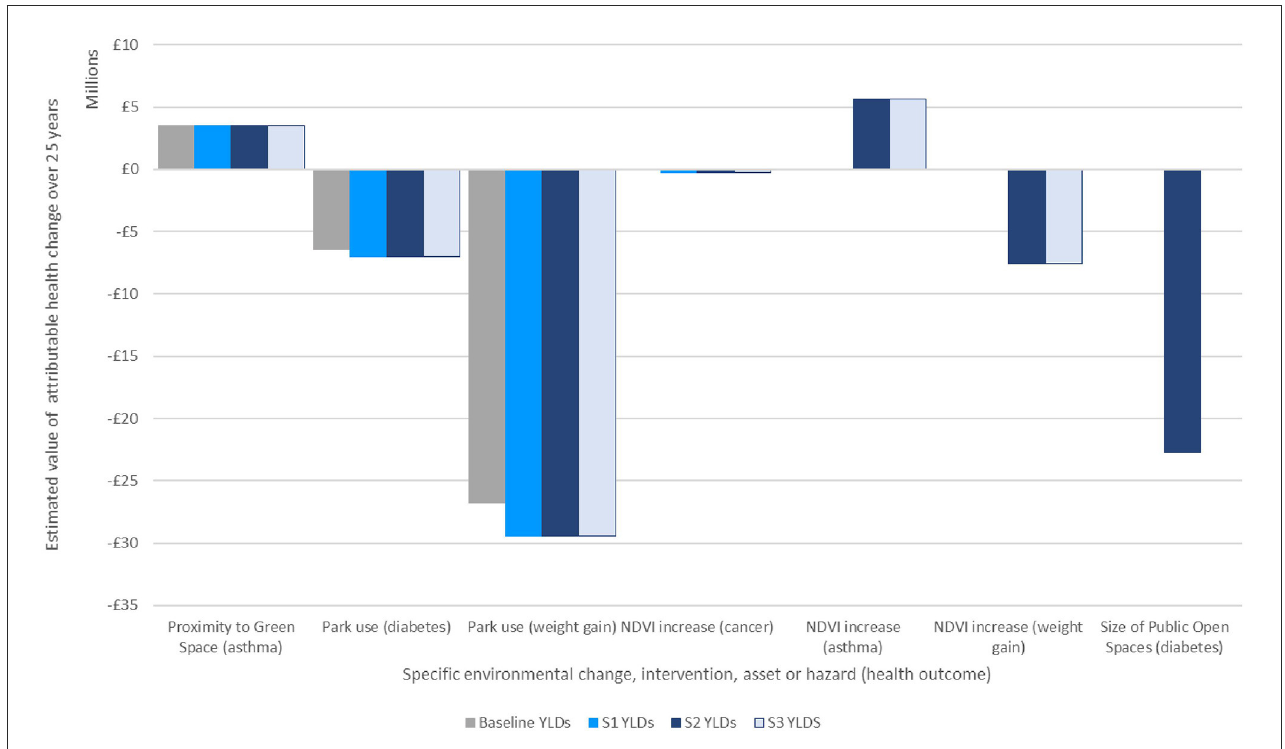
FIGURE5 Estimate of economic valuation of attributable changes to morbidity over 25 years under each scenario.